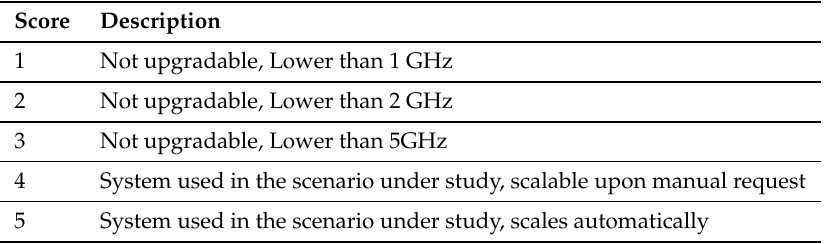
Table 4. Assessment of processing power attribute used for